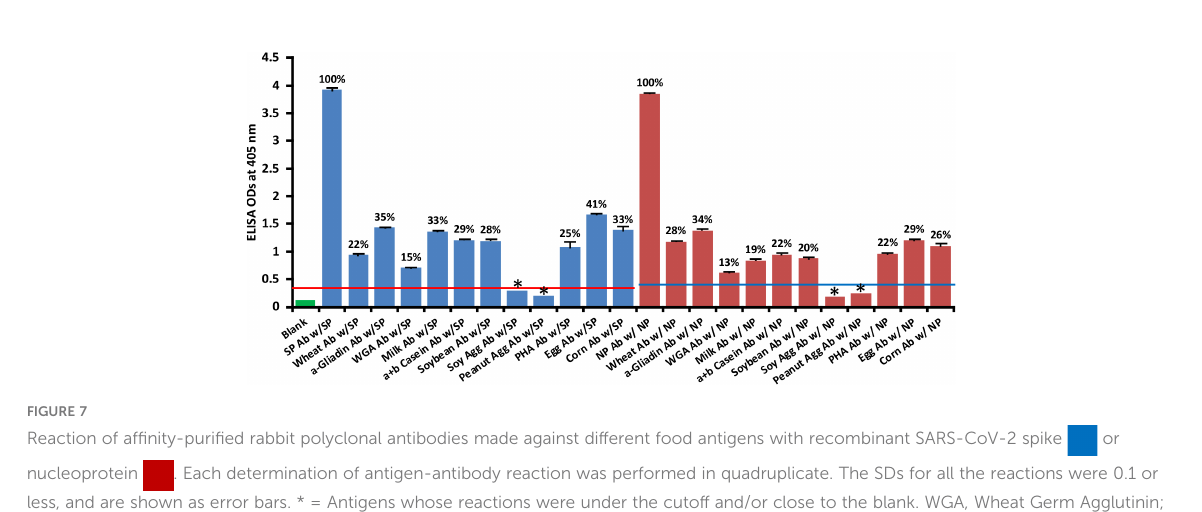
In Figure 8, the data shows that the reactions of human sera containing high levels of IgG antibody to peanut agglutinin and soy agglutinin with spike protein were comparable to those of sera containing low levels (negative) of antibody with non- signi fi cant p -values. However, most sera with high levels of IgG antibody against a -gliadin peptide, milk, a + b casein, and pineapple bromelain reacted strongly with SARS-CoV-2 spike protein, resulting respectively in p values of 0.020, 0.0003, 0.016, and 0.034.